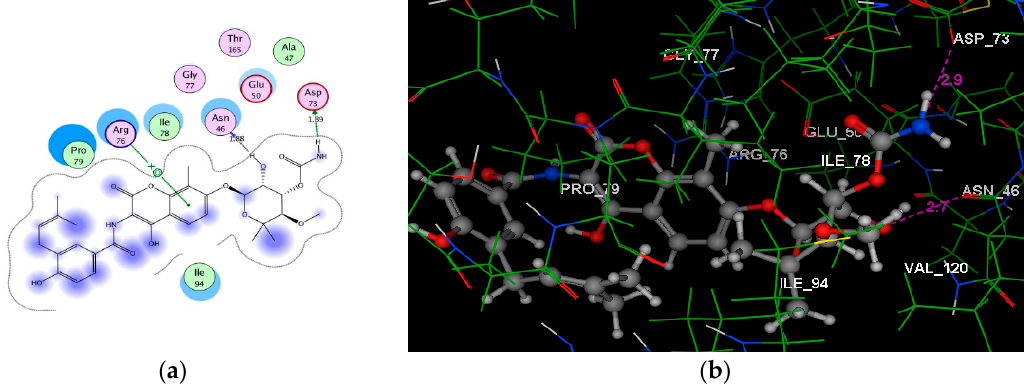
Figure 2. 2D ( a ) and 3D ( b ) diagrams illustrating the binding patterns of the co-crystallized ligand novobiocin into the ATP-active pocket of E. coli DNA gyrase B (PDB code: 1AJ6).